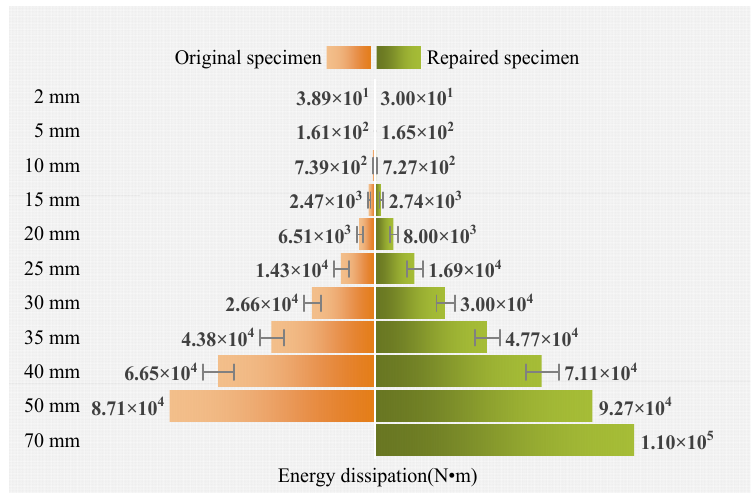
Figure 15. Comparison of energy dissipation at different displacement levels.